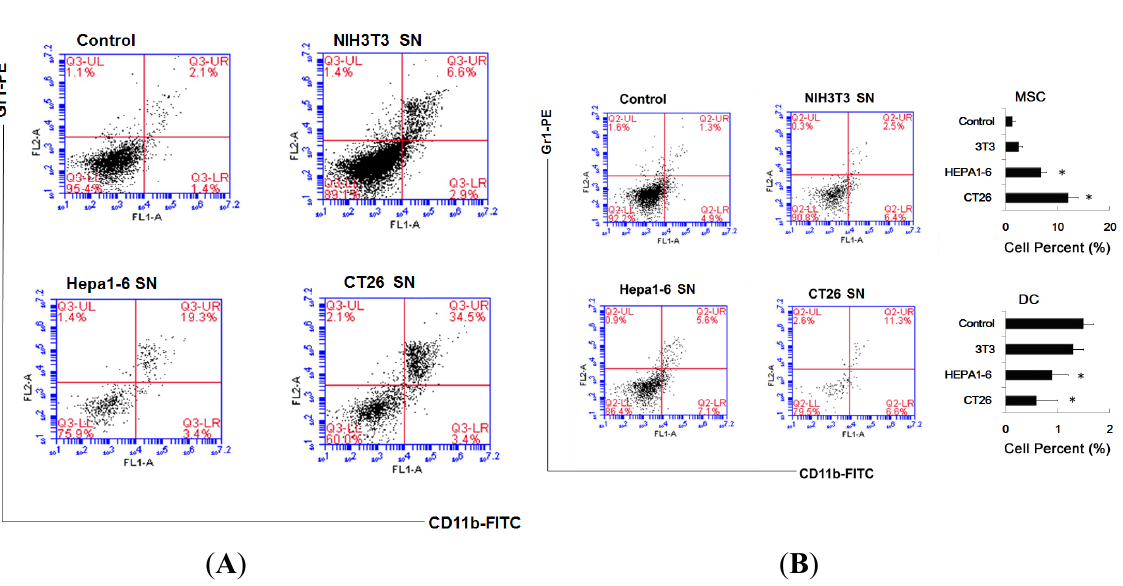
Figure 2. Supernatants of tumor cells inhibit DC and promoted MDSC accumulation. ( A ) Myeloid precursor cells co-cultured with supernatants method was indicated as previously. After co-culture, treated cells were washed with PBS 3 times, and doubled-labeled with Ab to Gr1 and CD11b, for phenotypic analysis by flow cytometry; ( B ) The percent of MDSC and DC in the spleen of tumor-bearing mice were assayed by FACS. Spleens were isolated from tumor-bearing mice, after depletion of red blood cells, were labeled Ab to Gr1 and CD11b or labeled Ab to CD11c. Percent of MDSC